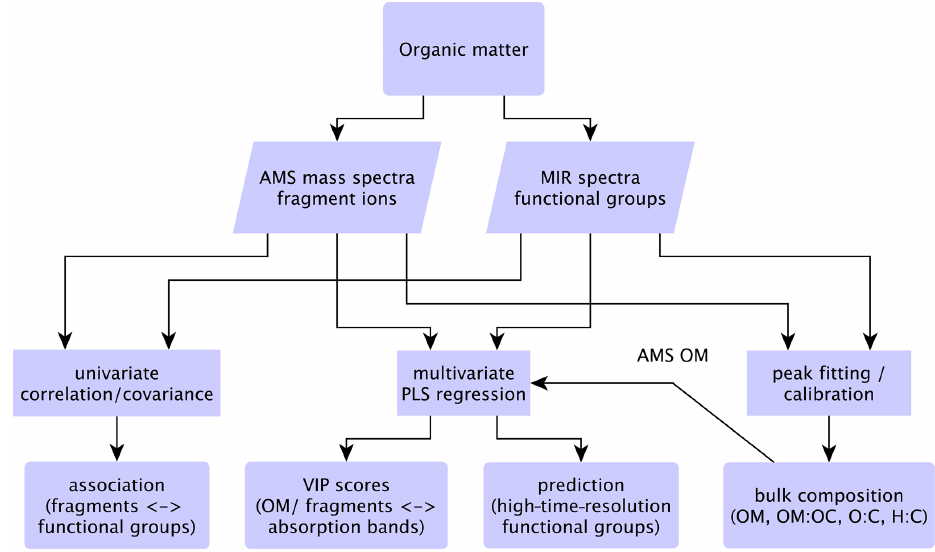
Figure 1. Statistical relations and strategy for comparison of MIR and AMS measurements. The correlation and covariance analyses are performed between AMS mass fragments and MIR functional group abundances from peak fitting. PLSR is performed using the AMS total OM or individual fragment concentrations as the independent variable and the MIR absorbance spectra as the dependent